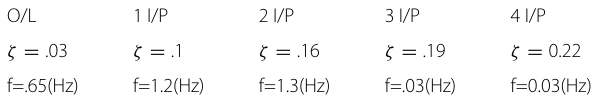
Table 3 Critical modes of closed loop power system for different number wide area control inputs(outputs of WRDC) O/L 2